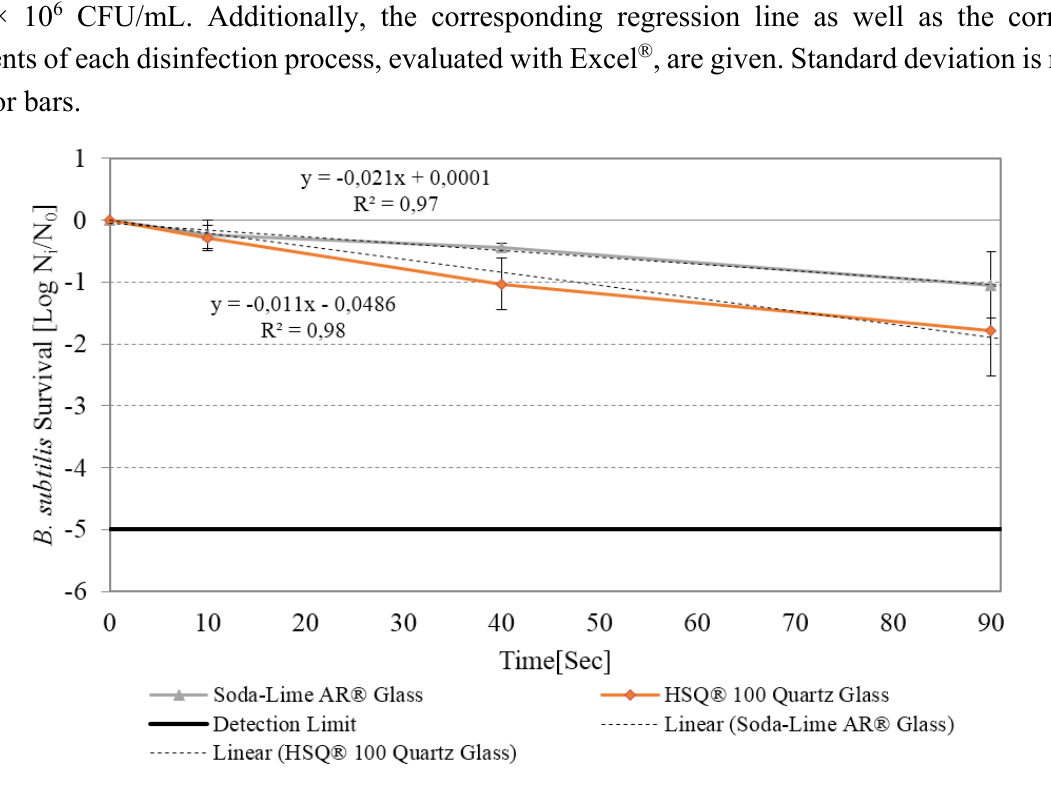
Figure 10. Disinfection results in log 10 for B. subtilis (1–3 × 10 6 CFU/mL) without additional mixing during UVC